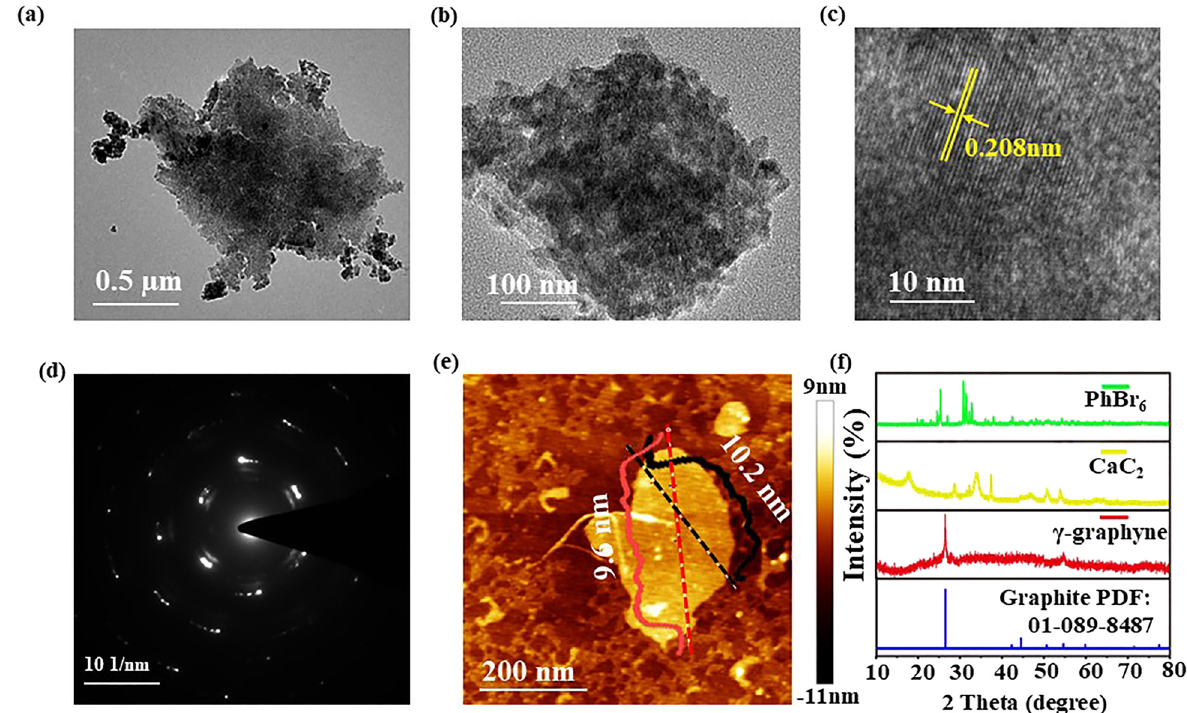
Figure 1: (a) TEM image in large scale, (b) TEM image of individual GDY flake, (c) HRTEM characterization of exfoliated graphdiyne, (d) SEAD pattern, (e) AFM cross section of graphdiyne nanosheets and (f) XRD spectra of graphdiyne